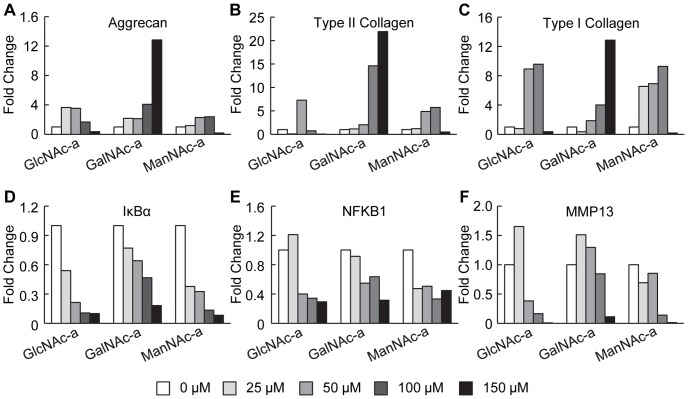
Effects of analog exposure on gene expression of IL-1β-stimulated chondrocytes in 3D hydrogels.Gene expression for ECM proteins (A) aggrecan, (B) type II collagen and (C) type I collagen, and inflammatory proteins (D) IκBα, (E) NFKB1 and (F) MMP13.